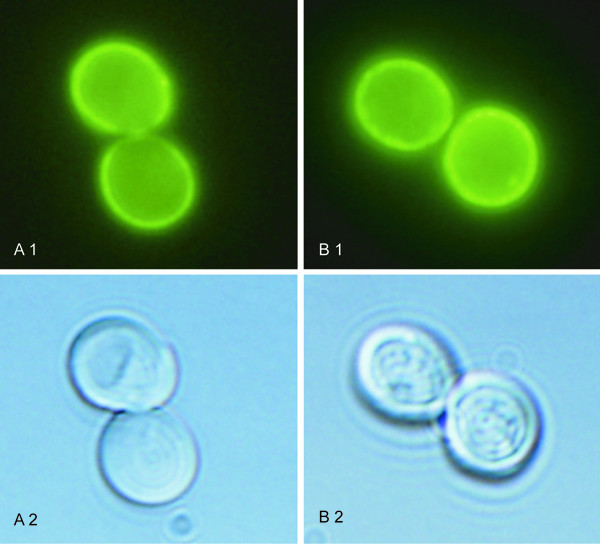
Localization of GFP-tagged CdCnh1p (A) and CpCnh1p (B) in BW31a cells. Fluorescence (1) and Nomarski (2) micrographs.